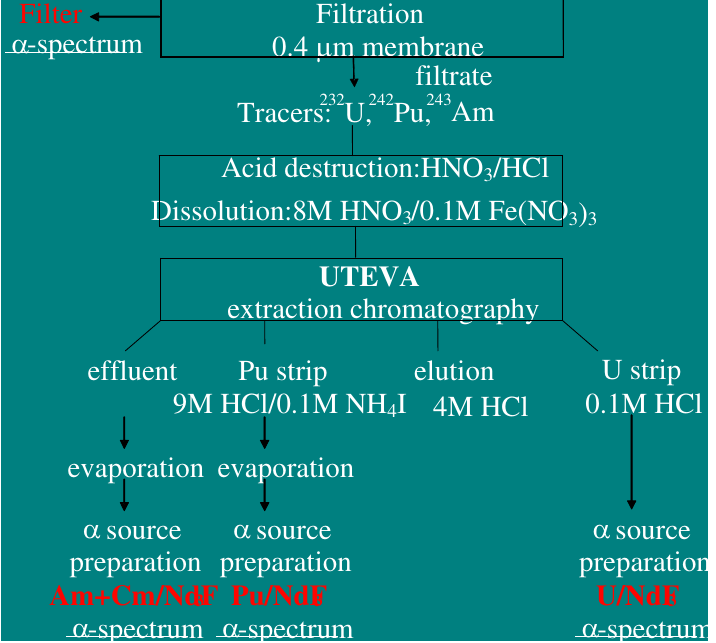
Fig. 2 Flowchart of the extraction chromatography for separation of Pu, Am/Cm and U isotopes. Hot particles collected from the primary circuit were analyzed by